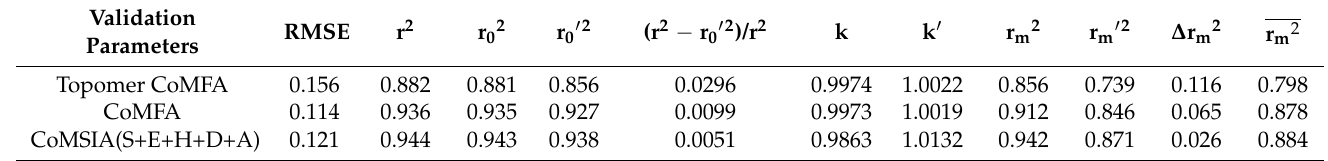
Table 3. External validation parameters of Topomer CoMFA, CoMFA, and CoMSIA